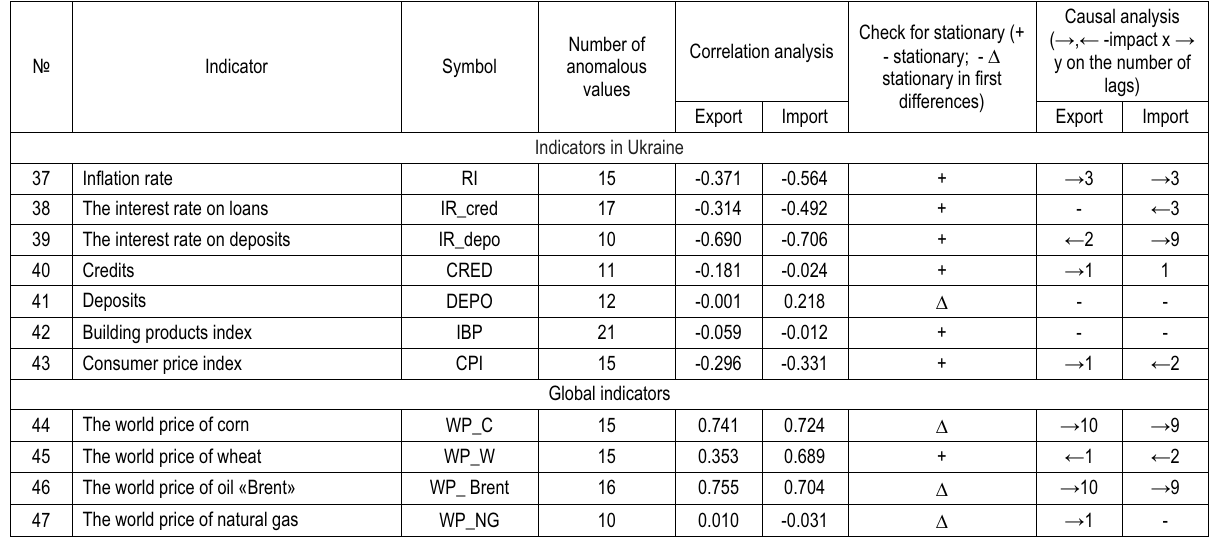
Table 1 (cont.). Conditional results of 2, 3 and 4 stages of VAR model construction